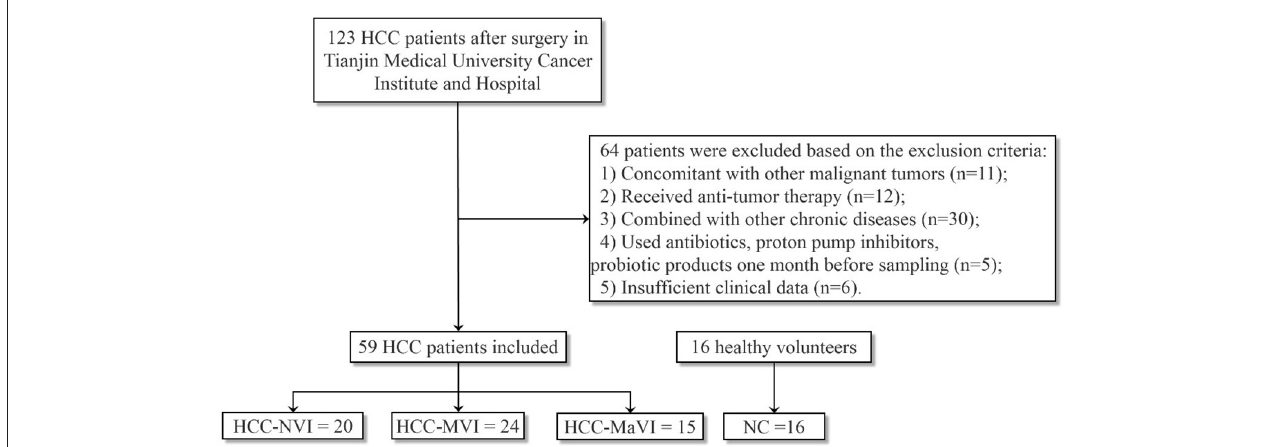
FIGURE 1 | Flow diagram describing the selection of the study